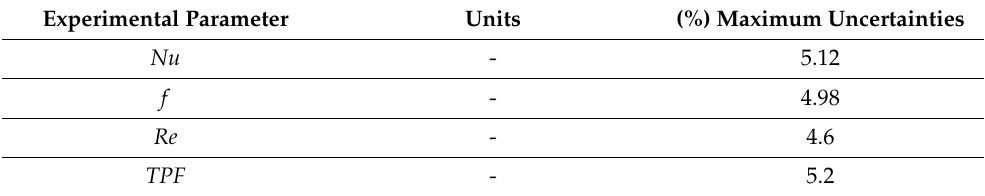
Table 2. Uncertainties of the experimental parameters.